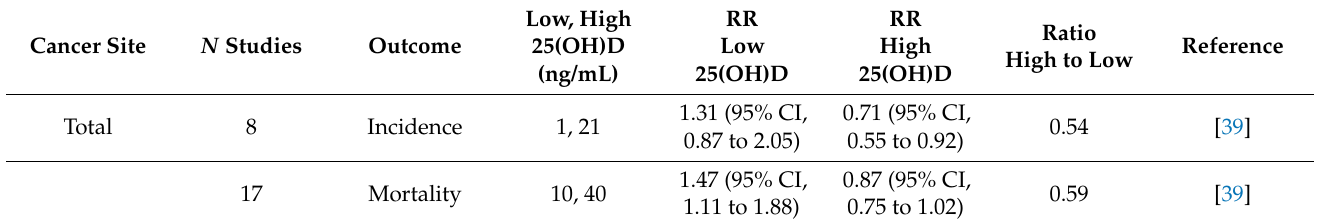
Table 4. Meta-analyses of cancer incidence and mortality rates from observational